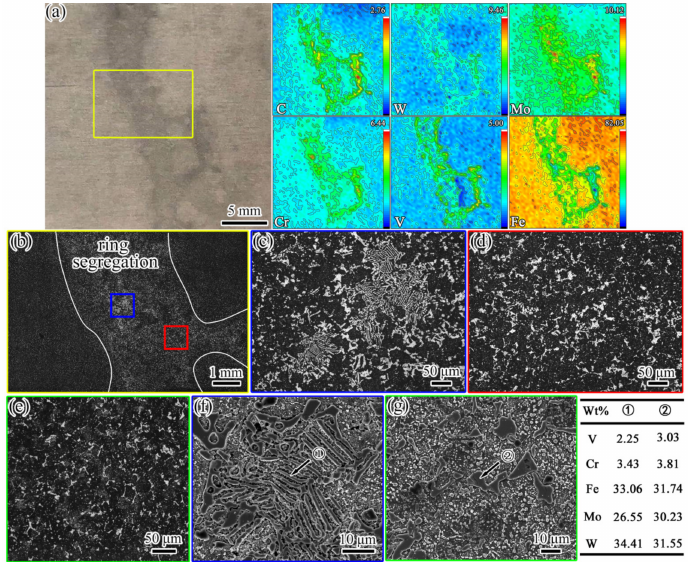
Figure 6. Images of composition and microstructure. ( a – d , f ) Sample #5; ( e , g ) sample #6. ( a ) The segregation morphology and alloying element distribution; the values in the top-right corner of each figure indicate the maximum concentration (red); ( b ) the microstructure (OM) of the area in the yellow box in ( a ); ( c , d ) the microstructure (OM) in the blue and red boxes in ( b ), respectively; ( e ) the microstructure (OM) of sample #4; ( f ) the SEM image of the fish bone-like carbide corresponding to ( c ); ( g ) the SEM morphology of the massive